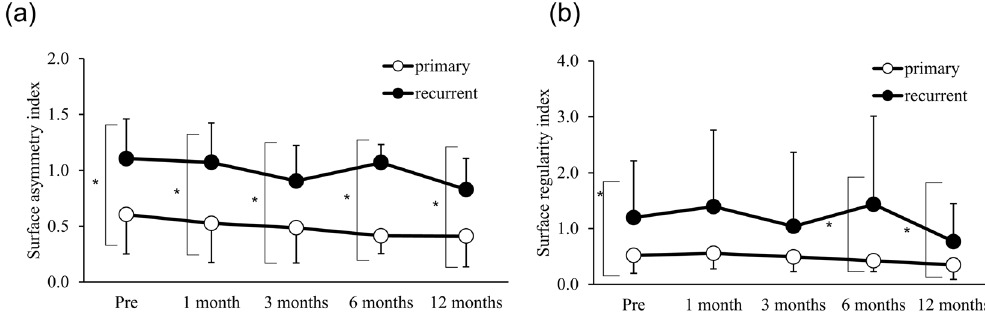
Figure 1. Surface asymmetry index (SAI) and surface regularity index (SRI) of grade 2 pterygium. ( a ) Preoperative and postoperative SAI of grade 2 pterygium. There was significant difference between primary and recurrent pterygium before and at 1, 3, 6, and 12 months after surgery ( * p = 0.01, 0.03, 0.02, 0.02, and 0.004, respectively). Compared to the preoperative values, there was no significant difference at any observation point in both primary and recurrent pterygium. ( b ) Preoperative and postoperative SRI of grade 2 pterygium. There was significant difference between primary and recurrent pterygium before and at 6 and 12 months after surgery ( * p = 0.02, 0.04, and 0.03, respectively). Compared to the preoperative values, there was no significant difference at any observation point in both primary and recurrent pterygium.